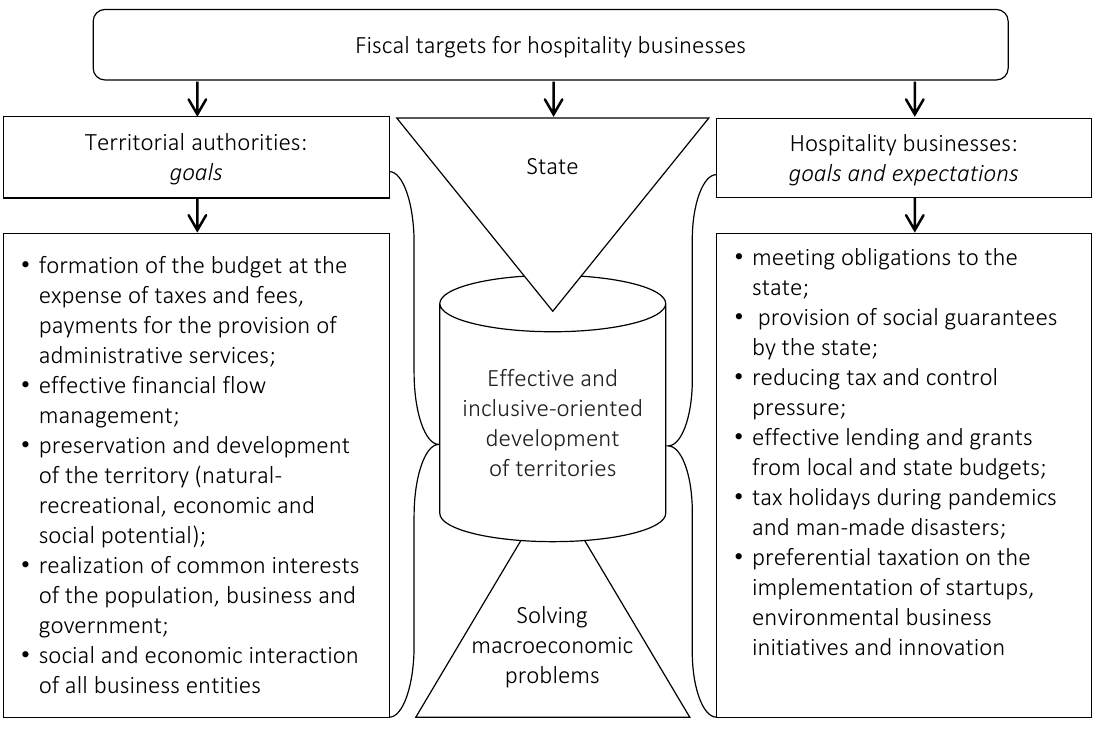
Figure 1. Fiscal targets for hospitality businesses in the territorial development